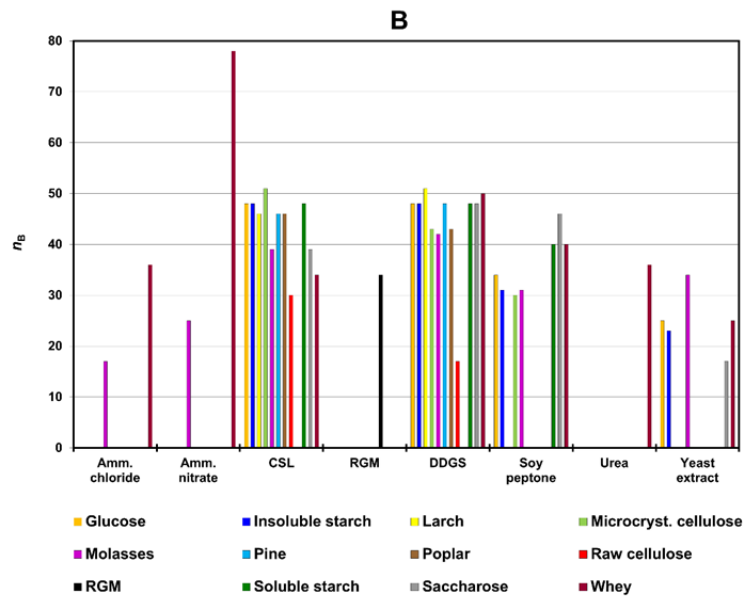
Figure 1. ( A ) Averaged values of the efficiency coefficient for a single component in two-component media (n Bav ); ( B ) obtained values of the efficiency coefficient (n B ) for two-component media in rela- relation to source no. two. Abbreviations: CSL—corn steep liquor; DDGS—dried distillers grains tion to source no. two. Abbreviations: CSL — corn steep liquor; DDGS — dried distillers grains with with solubles; RGM—reference growing solubles; RGM — reference growing medium.